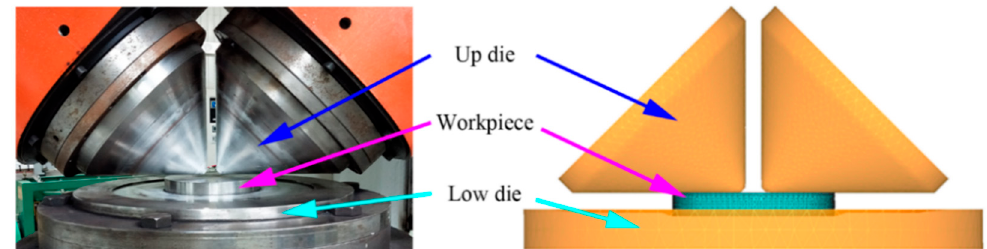
Figure 2. The numerical model of the integral forming of the large diameter thin-walled metal disk by double-roll rotary forging.